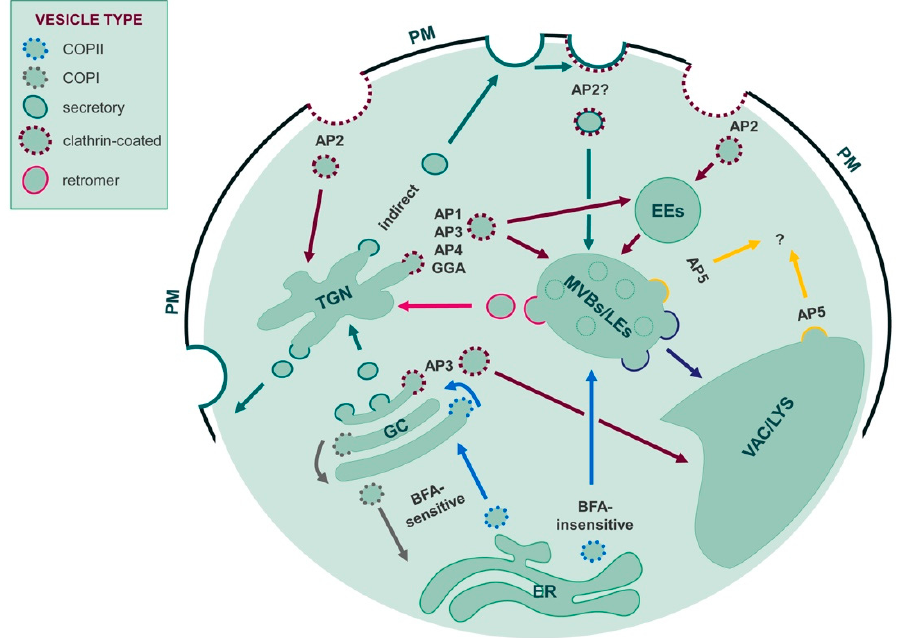
Figure 5. Biosynthetic and endocytic traffic routes to vacuoles/lysosomes. The color code of each arrow corresponds to that of the vesicle type involved. Traffic pathways are as follows. Blue, COPII mediated: BFA-sensitive ER to GC; anterograde intra GC cisternae; BFA insensitive ER to MVBs. Gray, COPI mediated: BFA sensitive GC to ER; retrograde intra GC cisternae. Wine, clathrin mediated: AP1-, AP3-, AP4-, GGA-mediated TGN to MVBs (plant cells) or TGN to EEs (animal cells); AP3-mediated GC to VAC (plant cells); AP2-mediated PM to TGN (plant cells) or EEs (animal cells). Notice that the TGN in plant cells also plays the role of animal EEs. Green, secretory vesicles: GC to TGN; TGN to PM. The TGN to MVBs/LEs indirect pathway could involve secretory vesicles from TGN to PM, followed by a possible AP2-mediated clathrin-coated vesicle internalization from PM to MVBs/LEs. Pink, retromer vesicles: MVBs/LE to TGN. Yellow: AP5-mediated traffic involved in maintaining lysosome integrity. Its exact role has to be elucidated, both in animals and plants. Violet: MVBs/LEs to VAC/LYS. Notice that this pathway seems to be a direct fusion event that does not require specific vesicles or coats. Abbreviations: ER, endoplasmic reticulum; GC, Golgi complex; TGN, trans-Golgi network; EEs, early endosomes; MVBs/LEs, multivesicular bodies/late endosomes; VAC/LYS, vacuole/lysosome; PM, plasma membrane; AP, adaptor protein complex; GGA, GGA adaptor-related proteins; BFA, Brefeldin A.